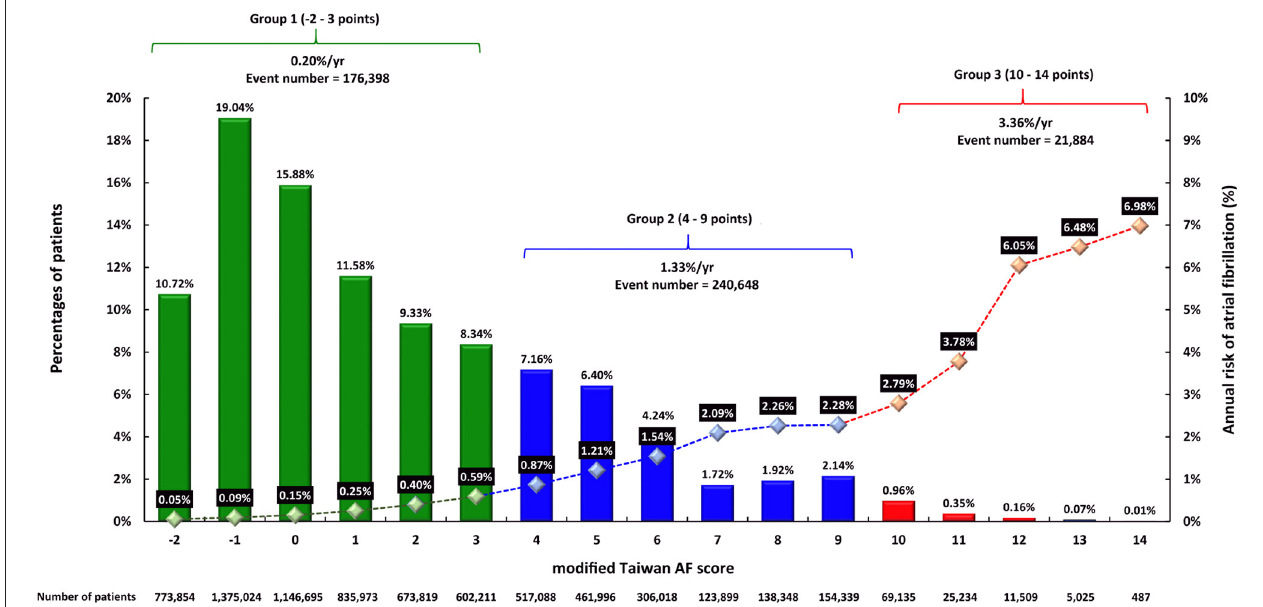
FIGURE 1 | The distributions of mTaiwan AF score and the risks of incident AF during 16-year follow-up. The mTaiwan AF score ranged between − 2 and 14. After a 16-year follow-up, the annual risk of incident AF increased from 0.05% for patients with a score of − 2 to 6.98% for patients with a score of 14. The annual risks of incident AF were 0.20, 1.33, and 3.36% for groups 1, 2, and 3, respectively. AF, atrial fibrillation.